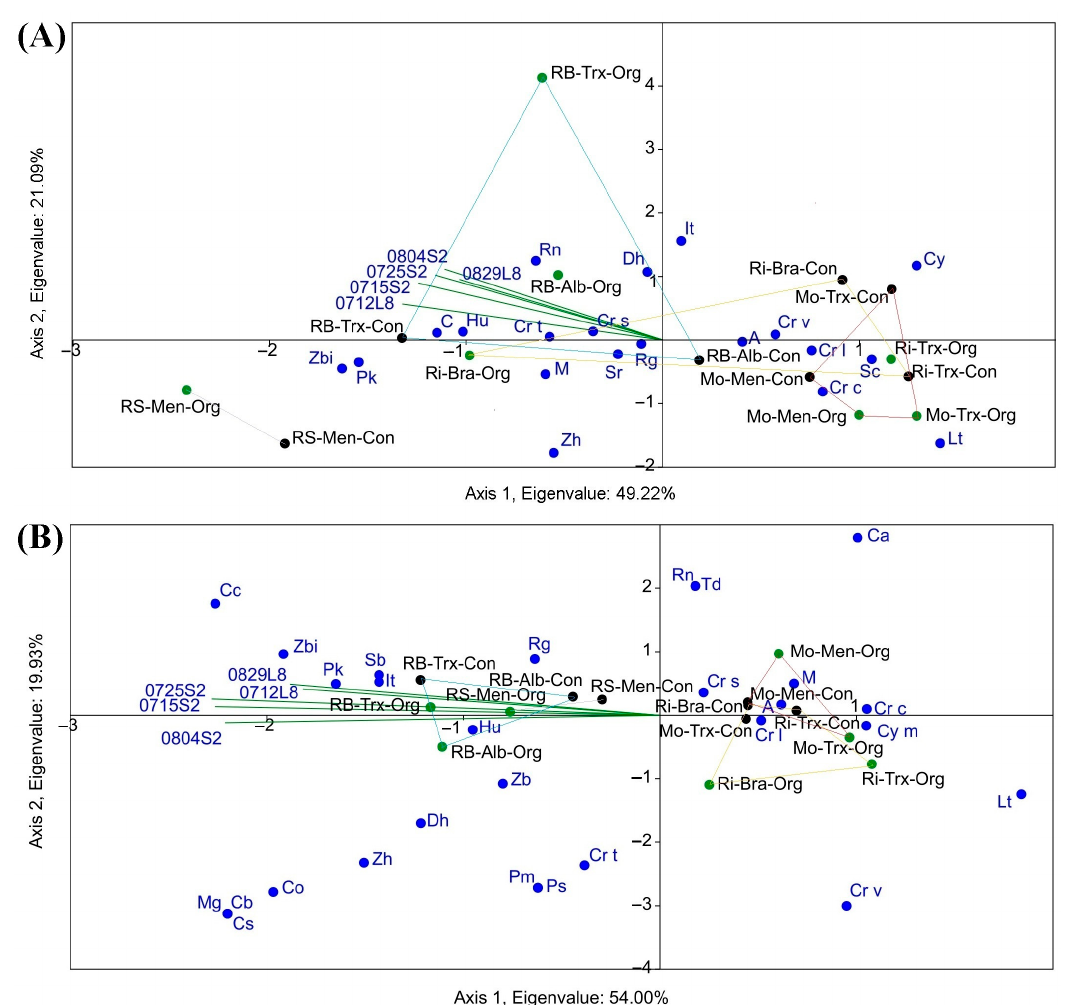
Figure 9. CCA between NDVI calculated using Sentinel-2 (S2) and Landsat-8 (L8) imagery at different dates (0804: 4 August; 0725: 25 July; 0715: 15 July; 0829: 29 August; 0712: 12 July) and regional yeast diversity in grapes ( A ) and musts ( B ) at frequency level (percentage or proportion of species: A, Aureobasidium spp.; C, Candida spp.; Ca, Candida apicola ; Cb, Candida bentonensis ; Cc, Candida californica ; Co, Candida oleophila ; Cs, Candida cf. sorbosivorans ; Cr, Cryptococcus spp.; Cr c, Cryptococcus carnescens ; Cr l, Cryptococcus laurentii ; Cr s, Cryptococcus stepposus ; Cr t, Cryptococcus terrestris ; Cr v, Cryptococcus victoriae ; Cy m, Cystofilobasidium macerans ; Dh, Debaryomyces hansenii ; Hu, Hanseniaspora uvarum ; It, Issatchenkia terricola ; Lt, Lachancea thermotolerans ; M, Metschnikowia spp.; Mg, Meyerozyma guilliermondii ; Pk, Pichia kluyveri ; Pm, Pichia membranifaciens ; Ps, Pichia sporocuriosa ; Rg, Rhodotorula graminis ; Rn, Rhodotorula nothofagi ; S, Starmerella bacillaris ; Sc, Saccharomyces cerevisiae ; Sr, Sporobolomyces ruberrimus ; Td, Torulaspora delbrueckii ; Zb, Zygosaccharomyces bailii ; Zbi, Zygosaccharomyces bisporus ; Zh, Zygoascus hellenicus/meyerae ) in the four DOs (Monterrei, Mo; R í as Baixas, RB; Ribeira Sacra, RS; Ribeiro, Ri) according to organic, Org (green) and conventional production system, Con (black), and cultivars (Albariño, Alb; Brancellao, Bra; Menc í a, Men; Treixadura,